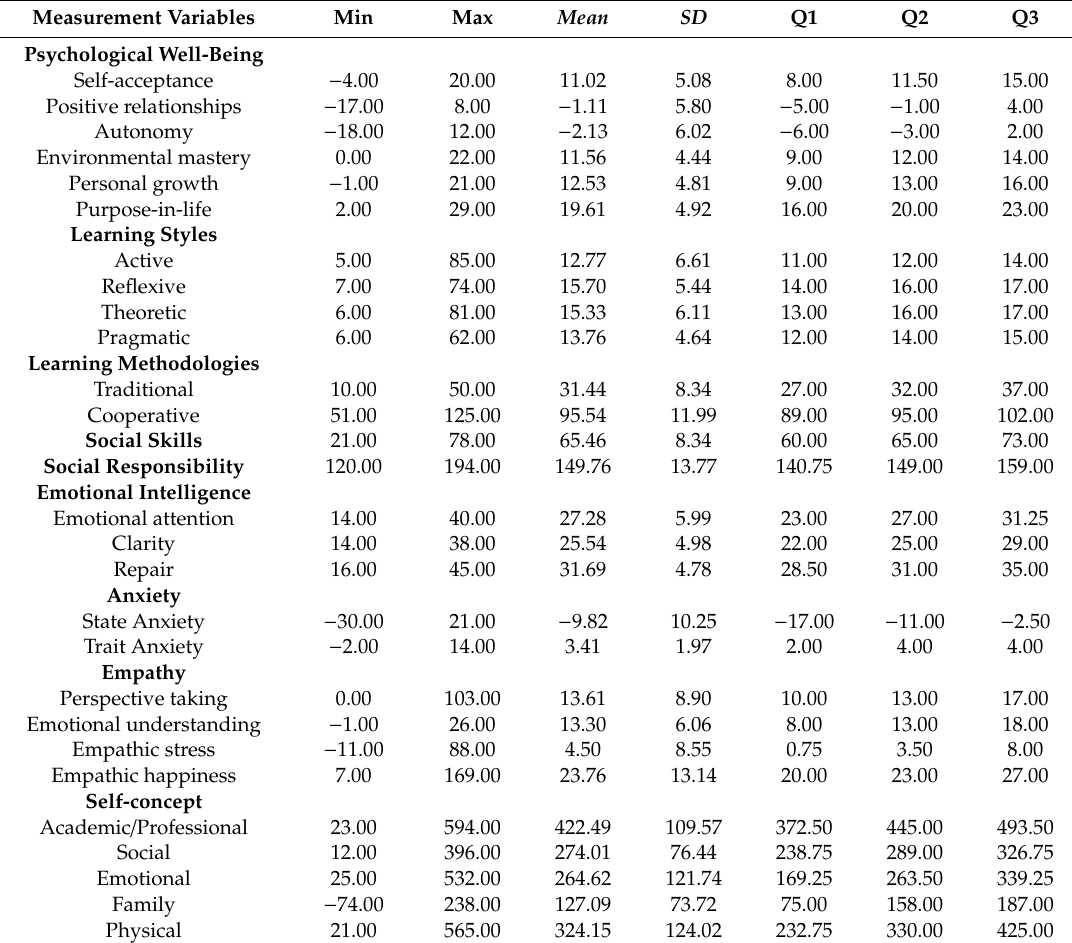
Table 1. Descriptive results (range, mean, SD and quartile scores) of psychological well-being, learning style and methodology, social skills, social responsibility, emotional intelligence, anxiety, empathy and levels of self-concept in university